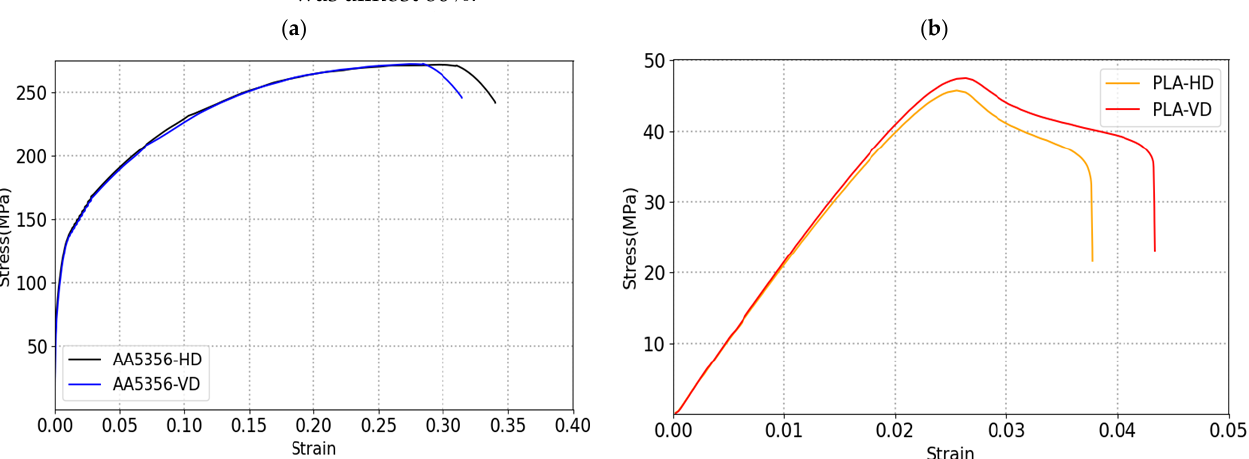
Figure 4. Engineering stress – strain curves of ( a ) AA5356 and ( b ) PLA in the HD and VD direc- tions.